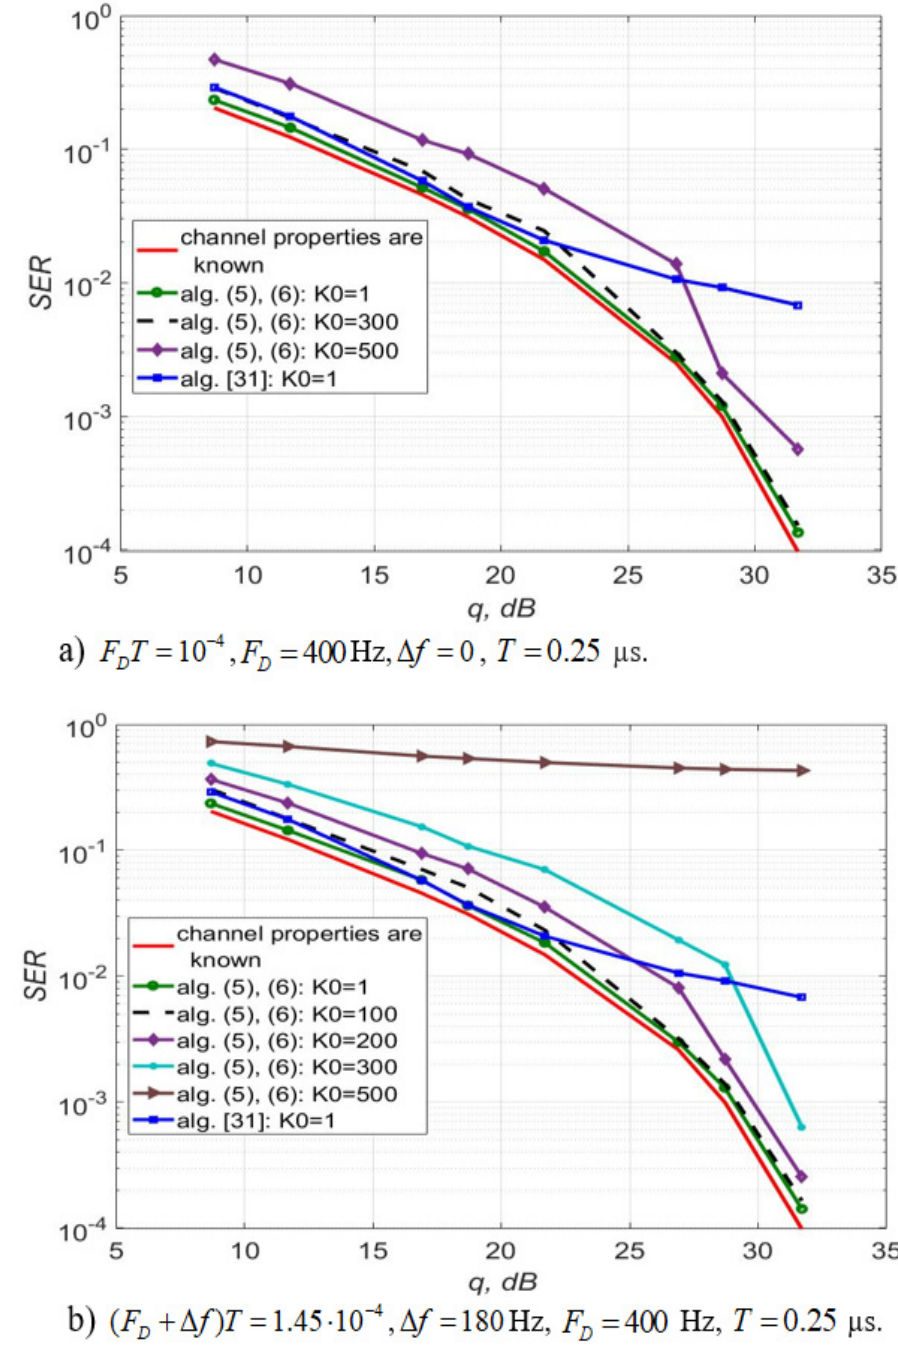
Figure 2. SER versus signal-noise ratio per bit for a 64-QAM signal in a channel with slow Rayleigh fading in the absence of IQ imbalance and DC offset using Equations (5) and (6) and from [31].